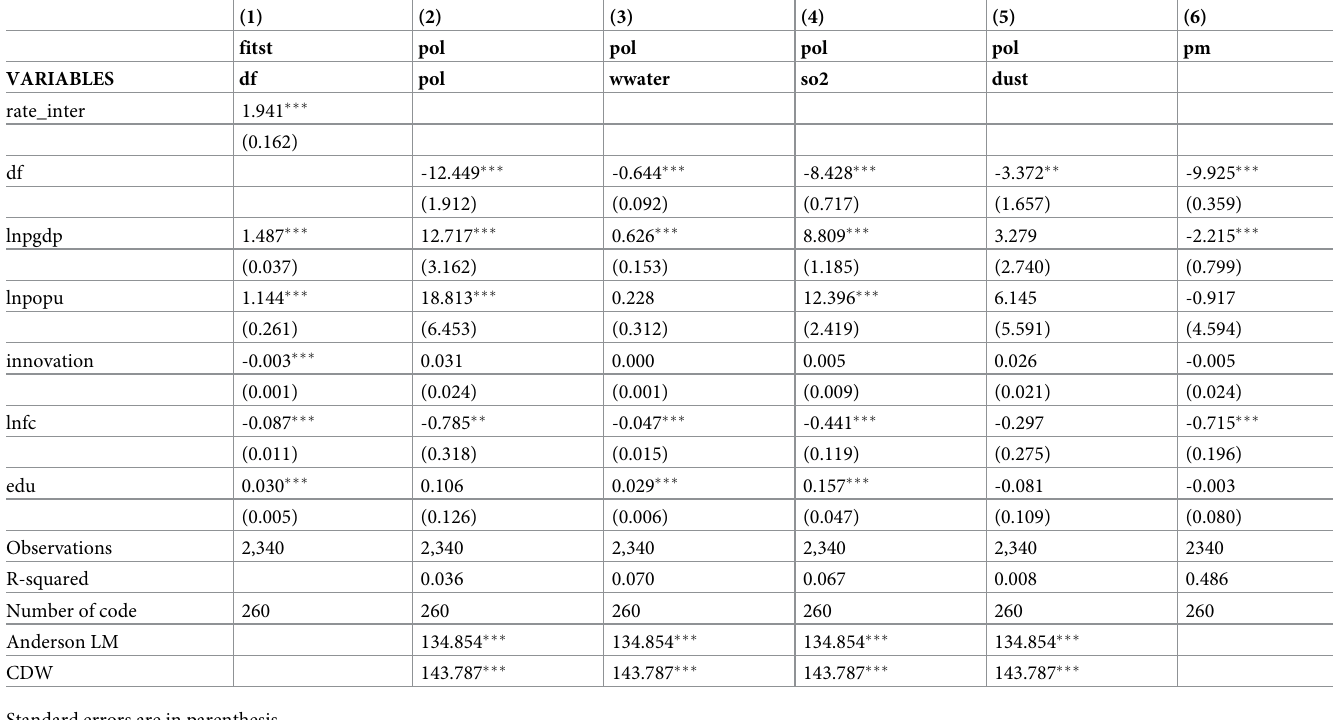
Table 11. Regression and robustness test results for instrumental